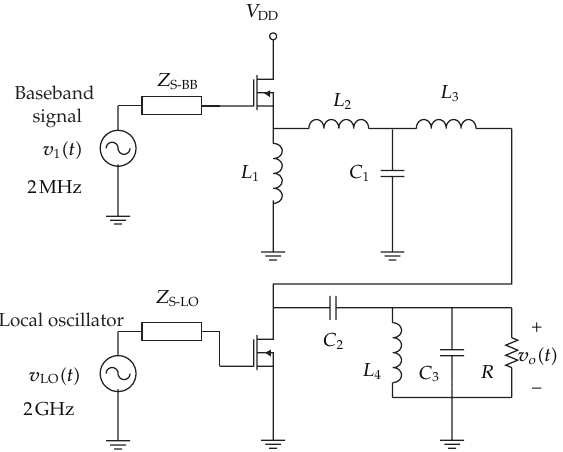
Figure 1: Simplified resistive FET mixer used in wireless transmit- ters.